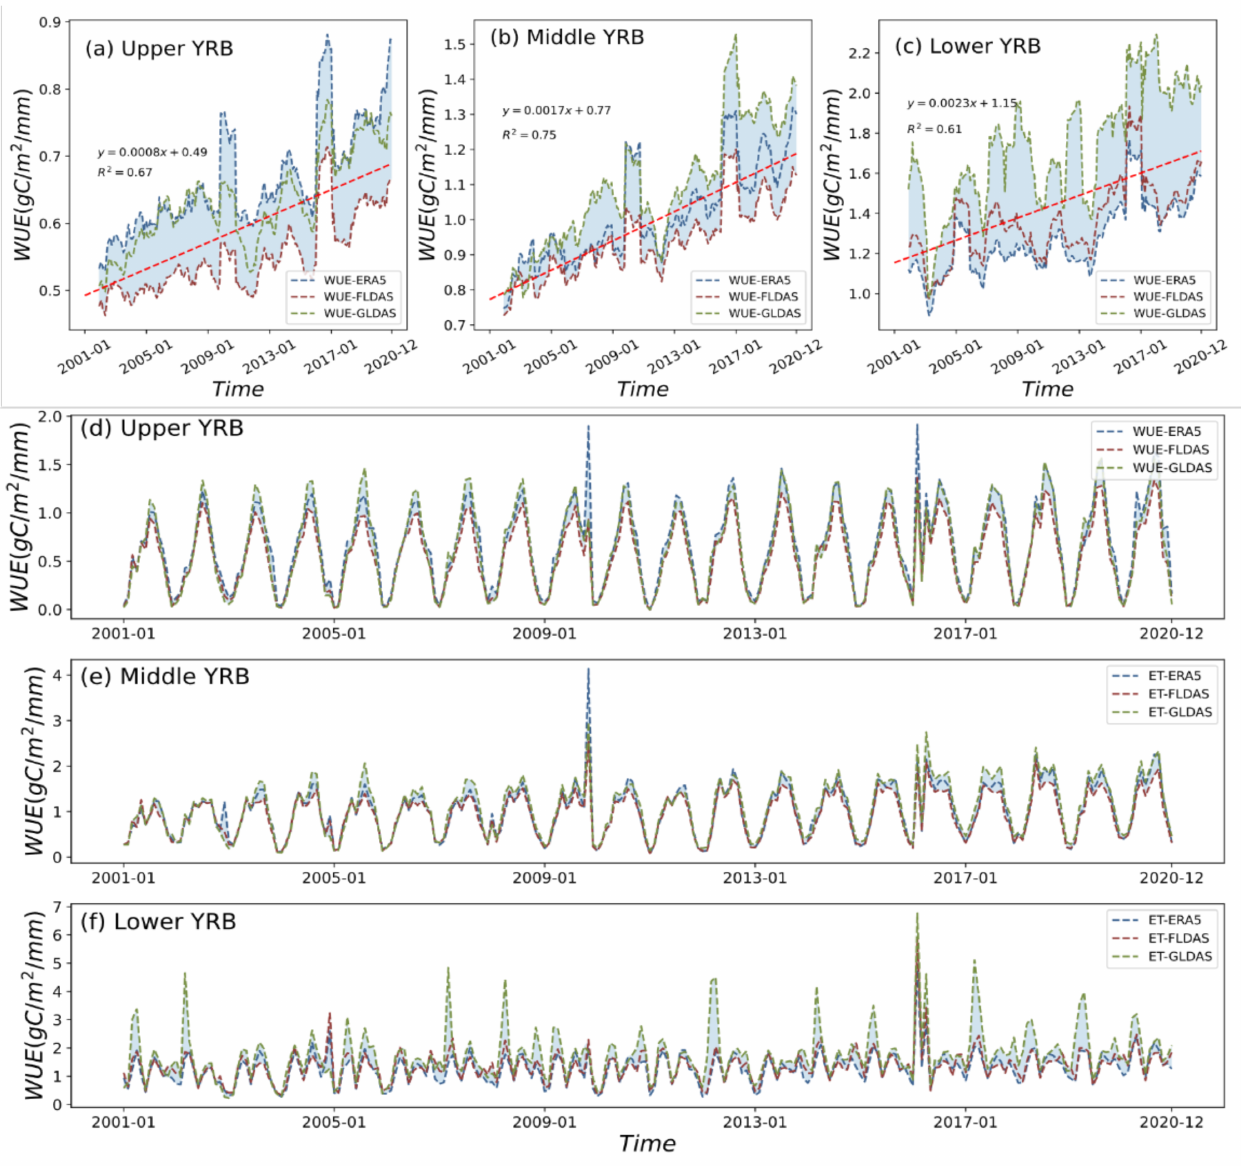
Figure 7. The annual ( a – c ) and monthly ( d – f ) variations in the mean WUE with three different data sources (ERA5, GLDAS, and FLDAS) in sub-basins of the YRB; Upper YRB: ( a , d ); Middle YRB: ( b , e ); Lower YRB: ( c , f